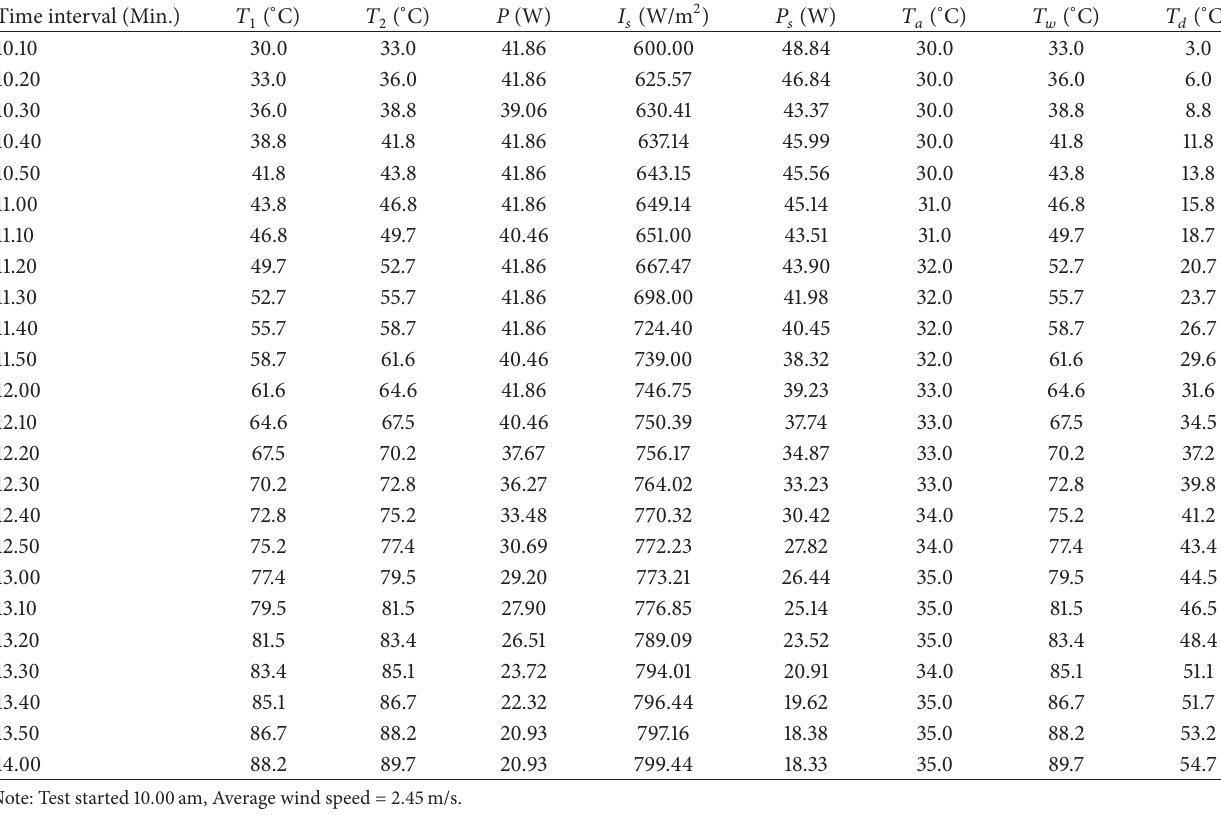
Table 4: Cooking power estimation (09/03/2013) .